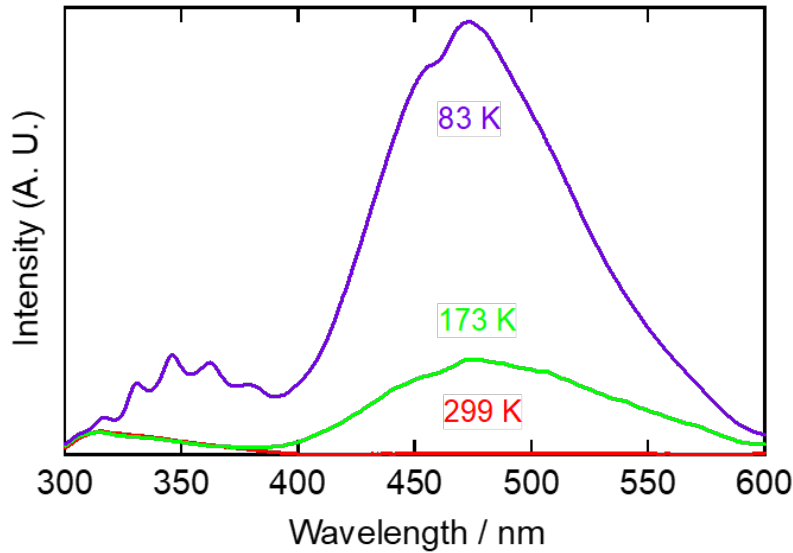
Figure 7. Solid-state temperature-dependent photoluminescence spectra at 83 K (violet line), 173 K (green line), and 299 K (red line) in [Ag(μ -L1Clpz)] n at 280 nm excitation.